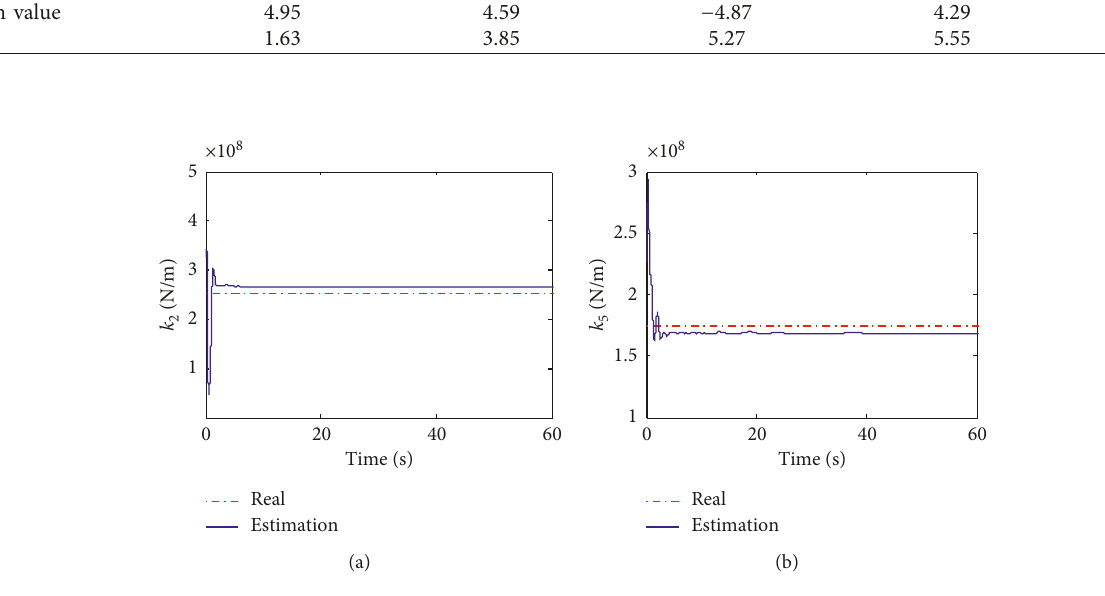
Figure 18: Estimation results of the equivalent stiffness coefficients.